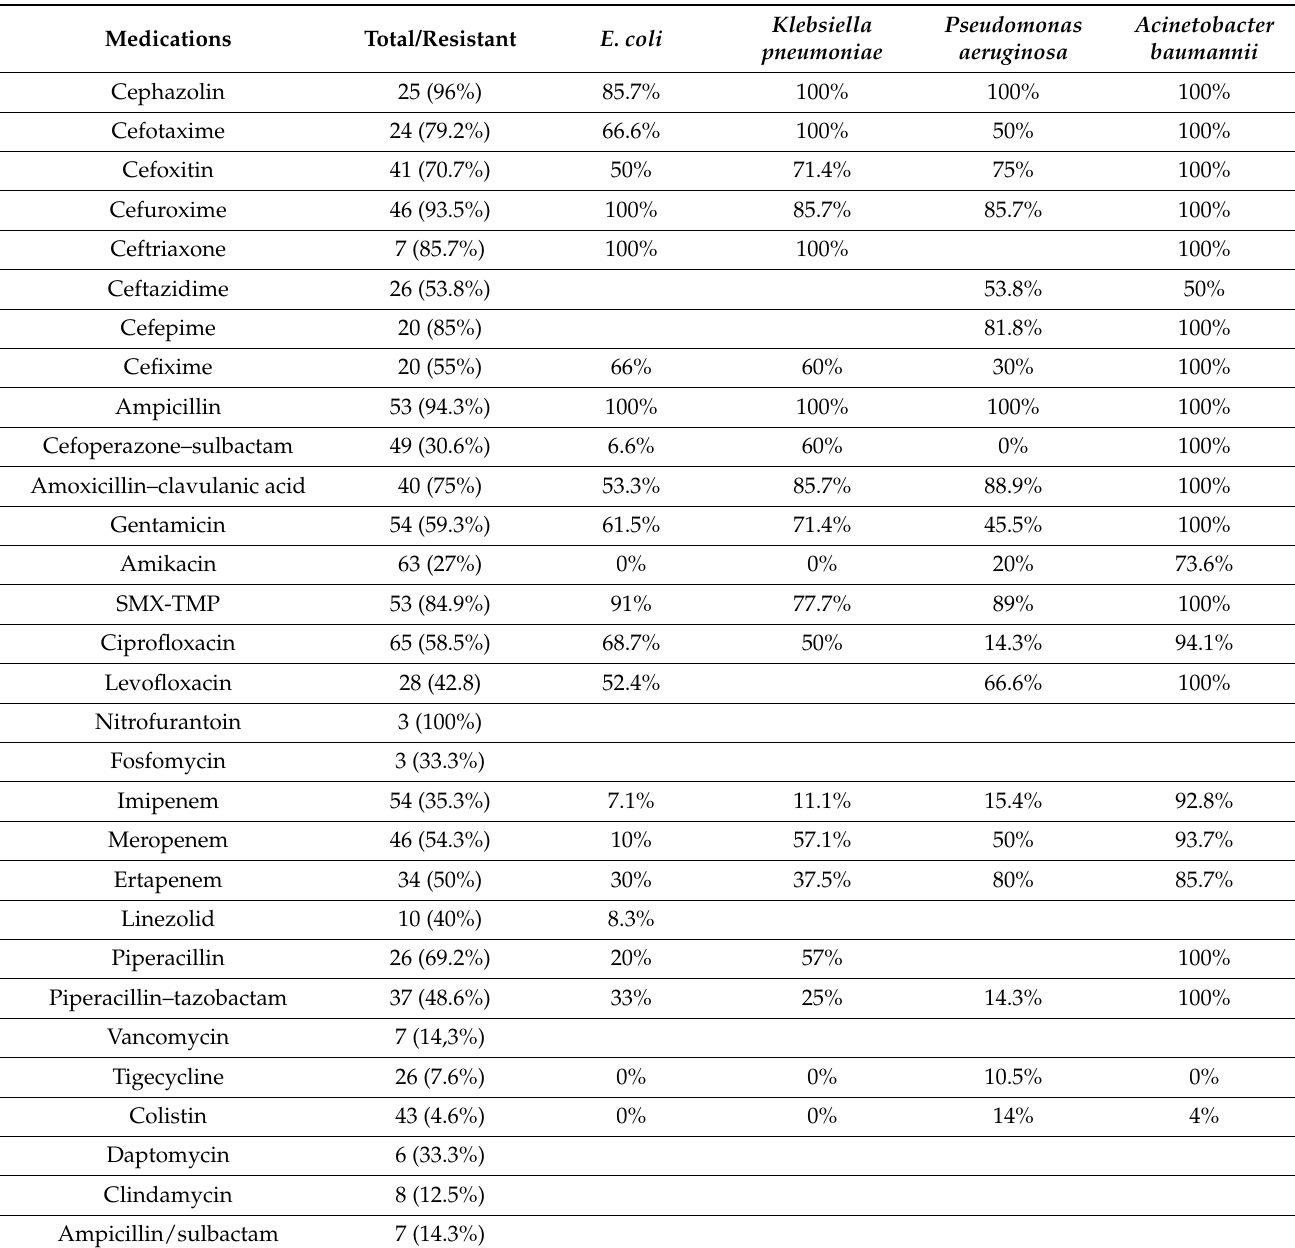
Table 3. The antimicrobial resistance pattern against the medications including specific antimicrobial resistance patterns against Gram-negative